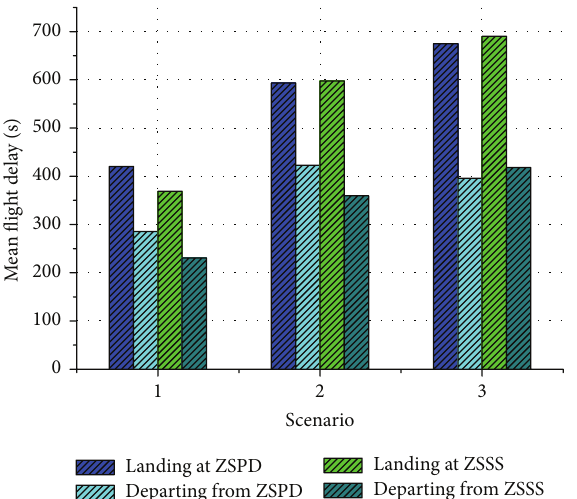
Figure 21: Statistics of flight delay for three scenarios.